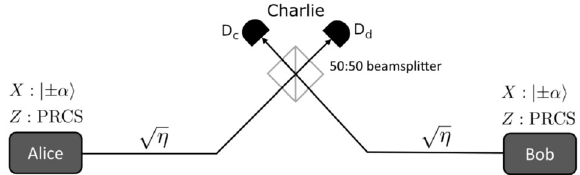
Fig. 1 Setup of the simple TF-QKD protocol 28 considered in this work. Alice and Bob generate their sifted key from the rounds in which they both select the X basis and Charlie declares that a single detector has clicked. The key bit is encoded in the phase of their coherent state. When the users select the same (a different) bit, the constructive (destructive) interference at Charlie ’ s 50:50 beamsplitter should cause a click in detector D c ( D d ). The Z -basis PRCSs are only used to estimate the phase-error rate of the X -basis generate the key, while the Z -basis data is used to estimate the detection statistics of Fock states, in combination with the decoy- state method. This is a crucial step in estimating the phase-error rate of the key, thus bounding the information that could have been leaked to a potential eavesdropper. The detailed steps of the protocol are: